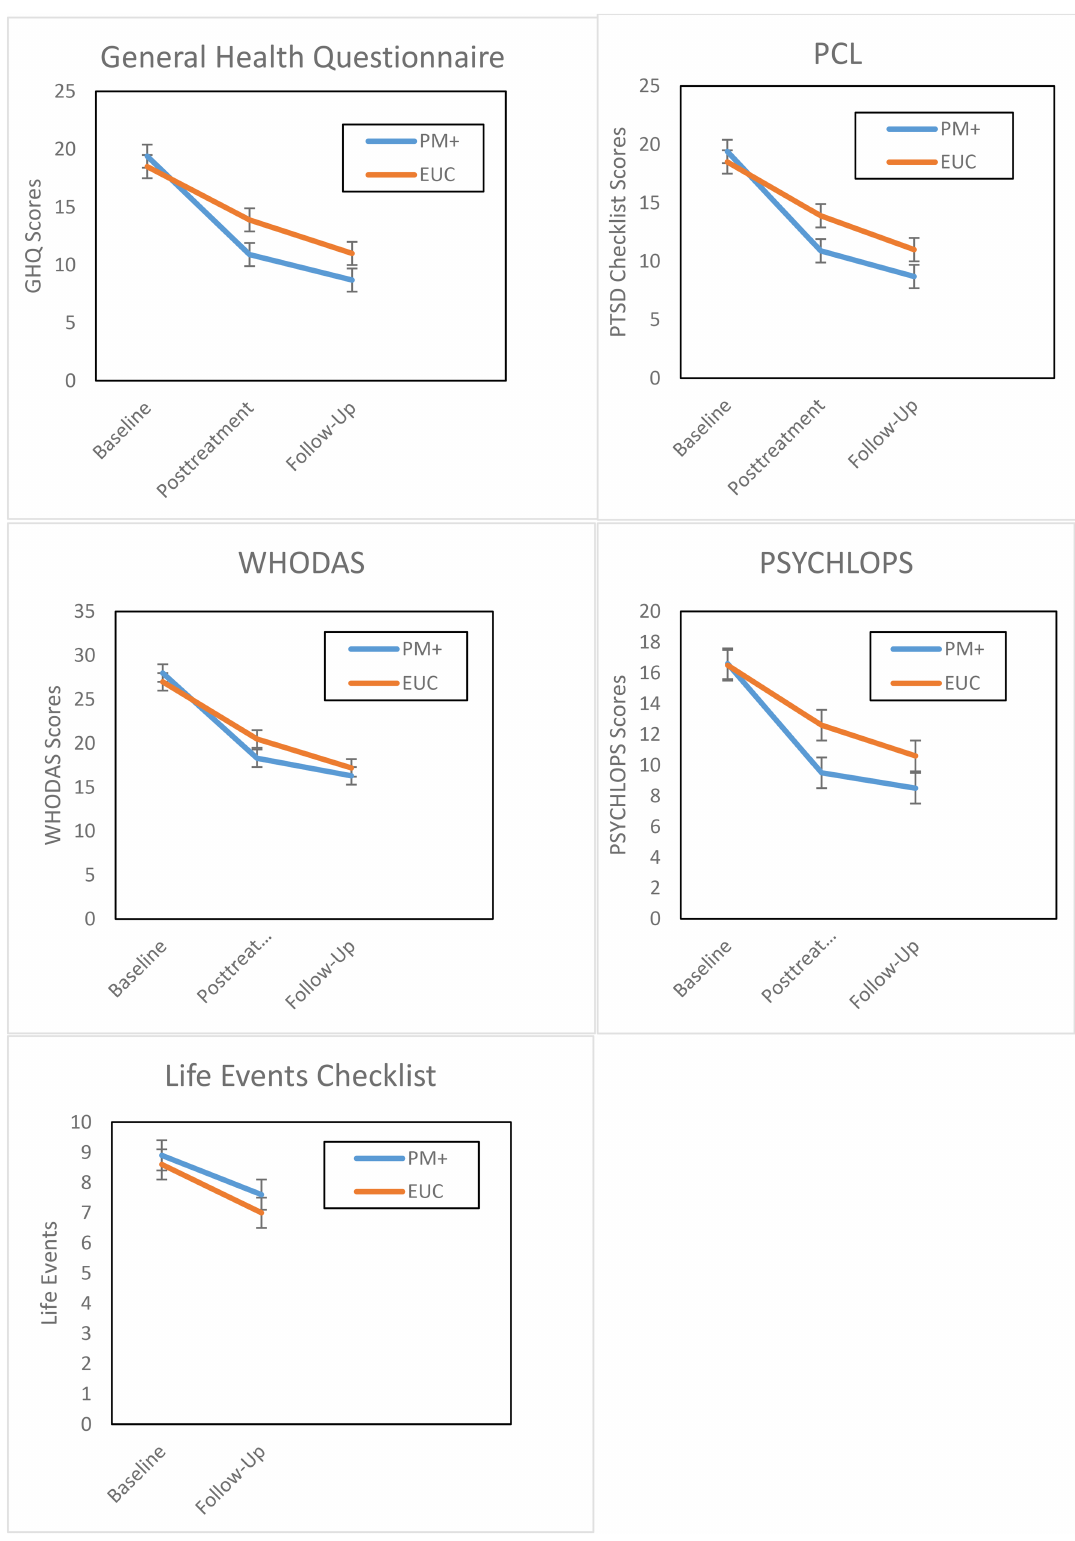
Fig 2. Estimated means of primary and secondary outcomes. Values basedon estimated means derived from hierarchicallinear model analyses. Error bars indicate 95% confidenceintervals. EUC, enhanced usual care; GHQ, General